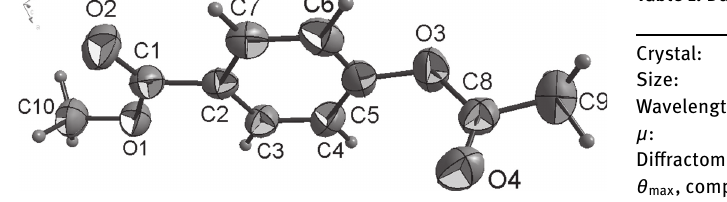
Table 1: Data collection and handling.